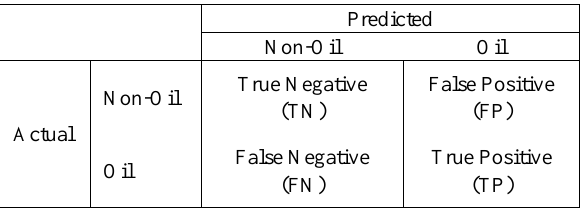
Table 1 . The confusion matrix.